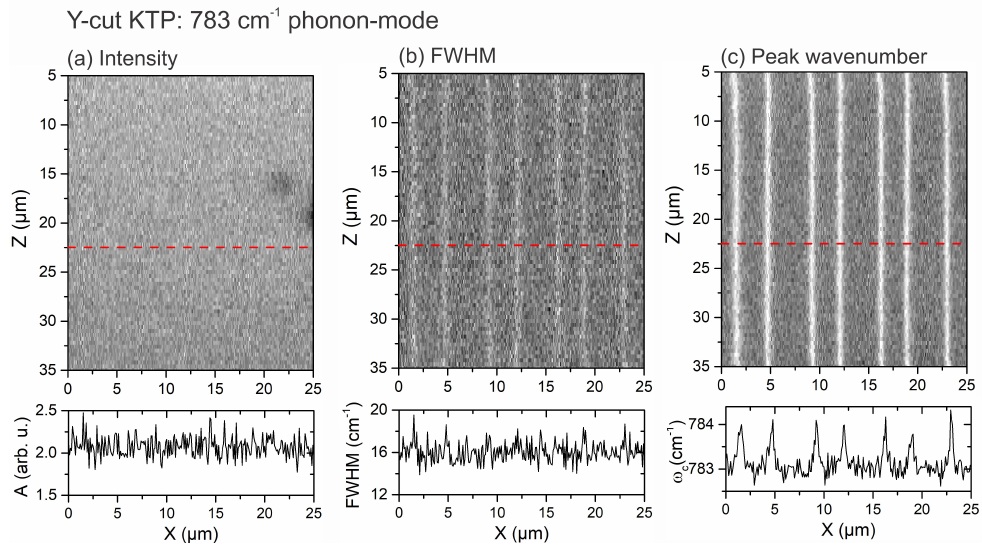
Figure 5. Raman images of the non-polar y-surface of a periodically poled KTP sample based on the variation of intensity ( a ), FWHM ( b ) and peak wave numbers ( c ) of the 783 − 1 phonon mode highlighted in Figure 4.